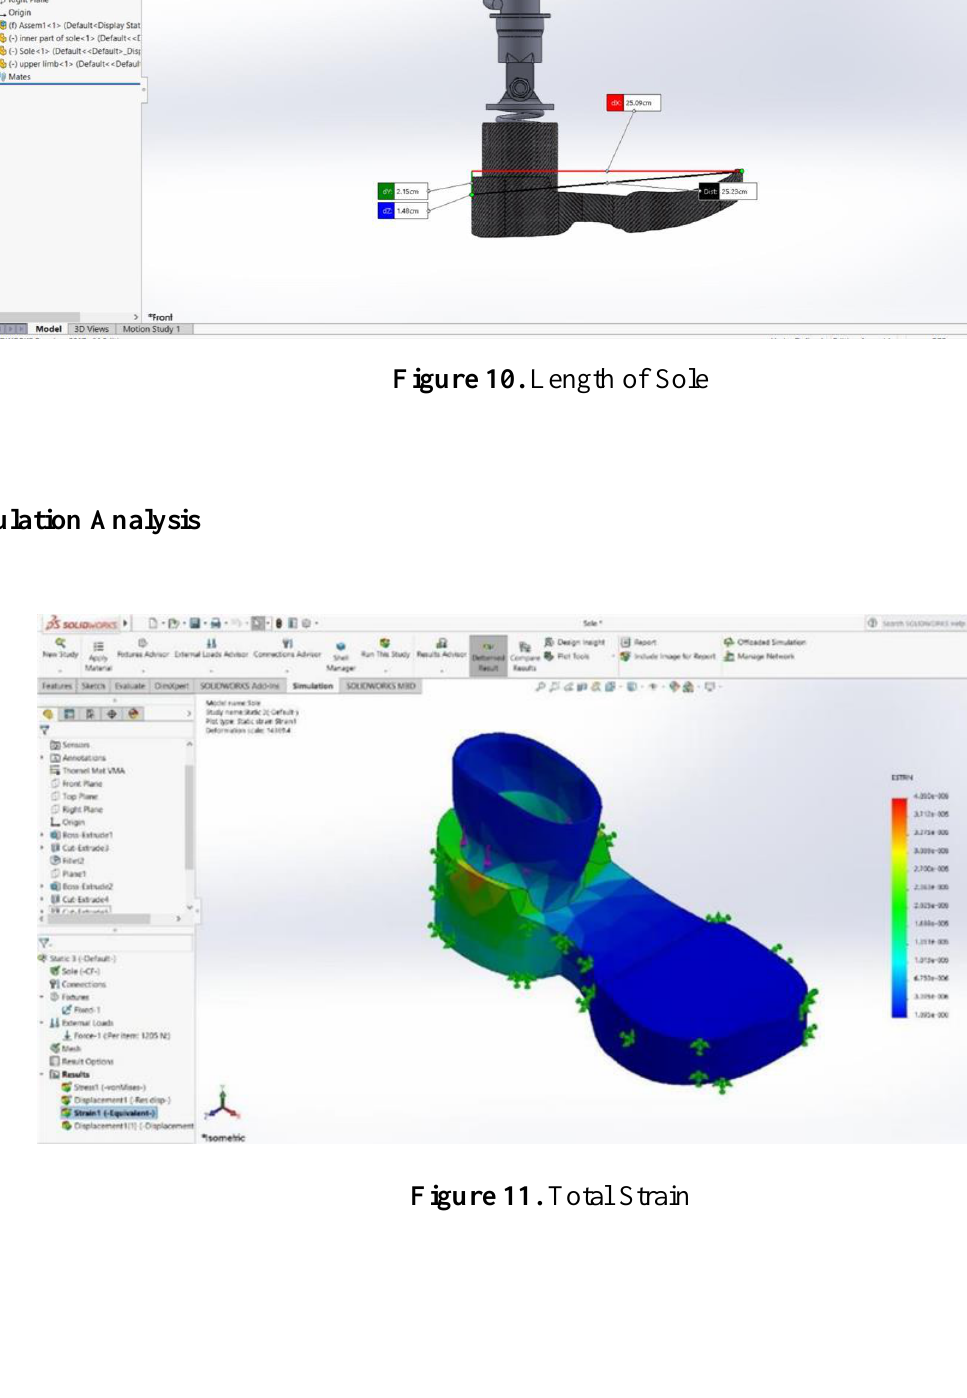
Figure 9. Height of Limbs